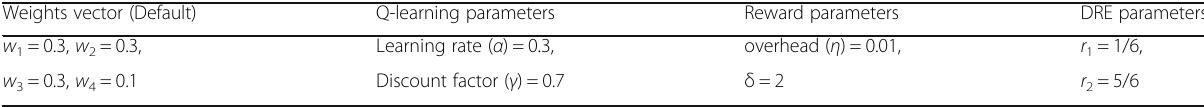
Table 2 Weight parameters Weights vector